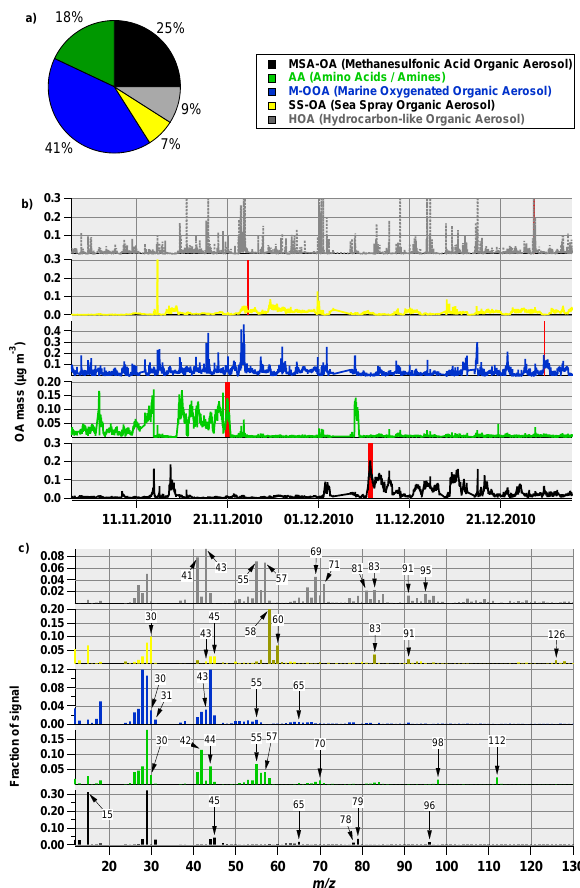
Fig. 5. Suggested 5-factor PMF solution for Bird Island organic aerosol: (a) pie chart of relative contributions per factor without salt ion fragments, (b) time series and (c) mass spectrum for each factor. The red vertical bars in (b) indicate the time periods used for HR PIKA analysis. The olive-coloured bars in (c) indicate m/z with major inorganic